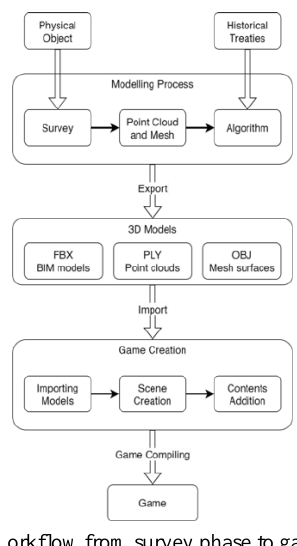
Figure 4 . Workflow from survey phase to game delivery.